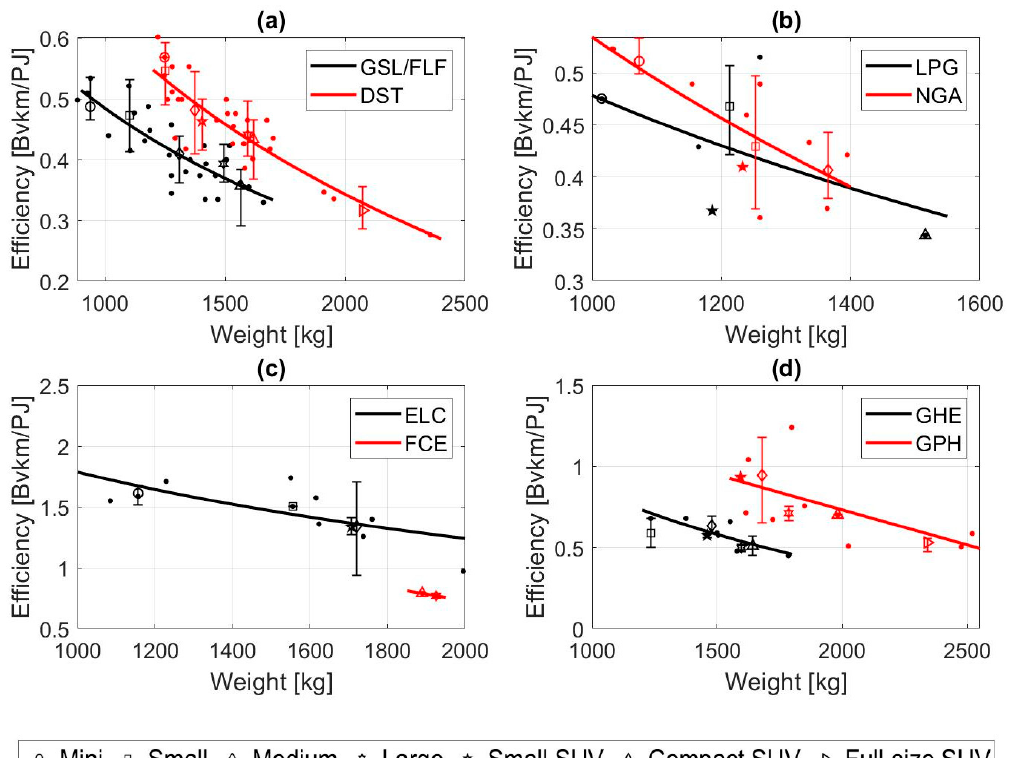
Figure 1. Efficiency trends as a function of vehicle weight for gasoline, flex-fuel and diesel cars/light trucks ( a ), for LPG and natural gas cars/light trucks ( b ), for fully electric and fuel cell cars/light trucks ( c ) and for gasoline–electric hybrid and gasoline–plug-in electric hybrid cars/light trucks ( d ), respectively: data-points represent the collected efficiency data, while the different size categories (Mini, Small, Medium, Large, Small SUV, Compact SUV and Full-Size SUV) are represented by the mean values of their respective weight-efficiency couple. Table 5. Average efficiency values (in billion vehicle-kilometers ( (cid:1828)(cid:1874)(cid:1863)(cid:1865)/(cid:1842)(cid:1836) ) for all car and light truck size categories.